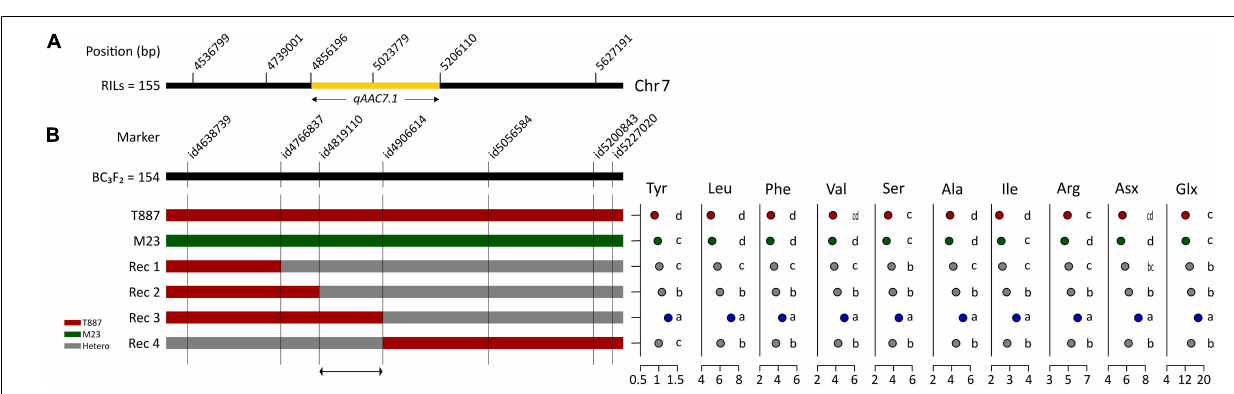
FIGURE 4 | Selection of qAAC7.1 recombinants. (A) qAAC7.1 region detected by primary mapping in RILs. (B) Selection of qAAC7.1 recombinants using BC 3 F 2 population. Different letters indicate significant differences between groups ( p ≤ 0.05, Tukey’s HSD test). Red and green bar indicate the homozygotes with T887 and M23 allele, respectively. The gray bar indicates the